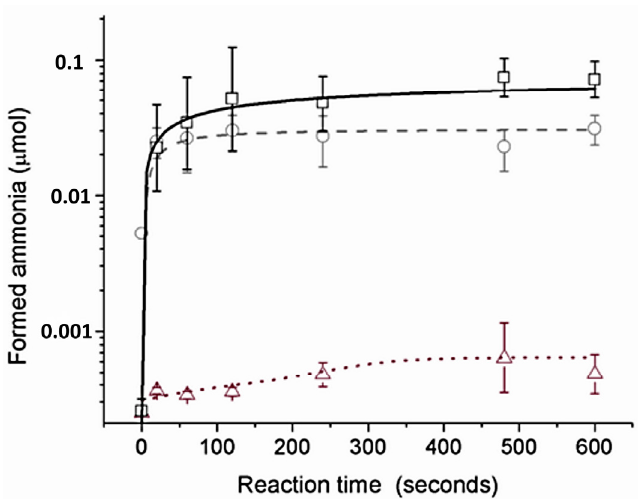
Figure 4. Quantification of formed ammonia over reaction time with urease enzyme (solid black (cid:3) ), with (2) (gray dashed line, ), and with (1) (red dotted line, (cid:52) ). Error bars gave the mean of three line, □ ), with (2) (gray dashed line, ○ ), and with (1) (red dotted line,  ). Error bars gave the mean (cid:35) independent catalytic of three independent catalytic experiments.